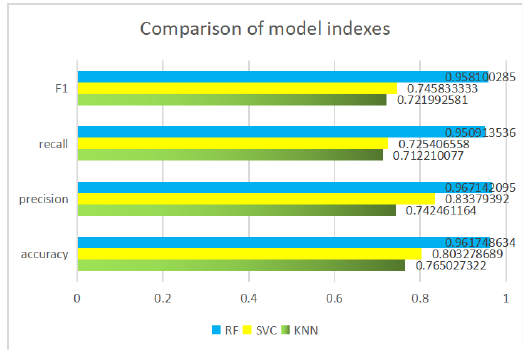
Figure 9. Comparison of three classification model indicators.